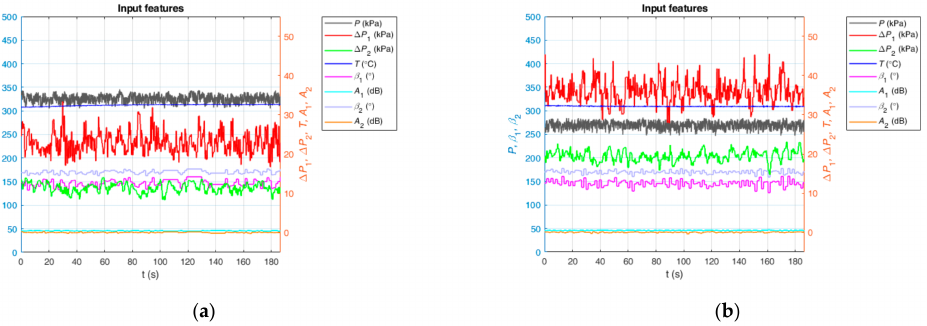
Figure 4. Two data samples of different working conditions. ( a ) Corresponding reference volume flow rates: Q o = 5.10 m 3 /h, Q g = 17.02 m 3 /h, Q w = 2.90 m 3 /h; ( b ) Corresponding reference volume flow rates: Q o = 4.86 m 3 /h, Q g = 28.54 m 3 /h, Q w = 3.90 m 3